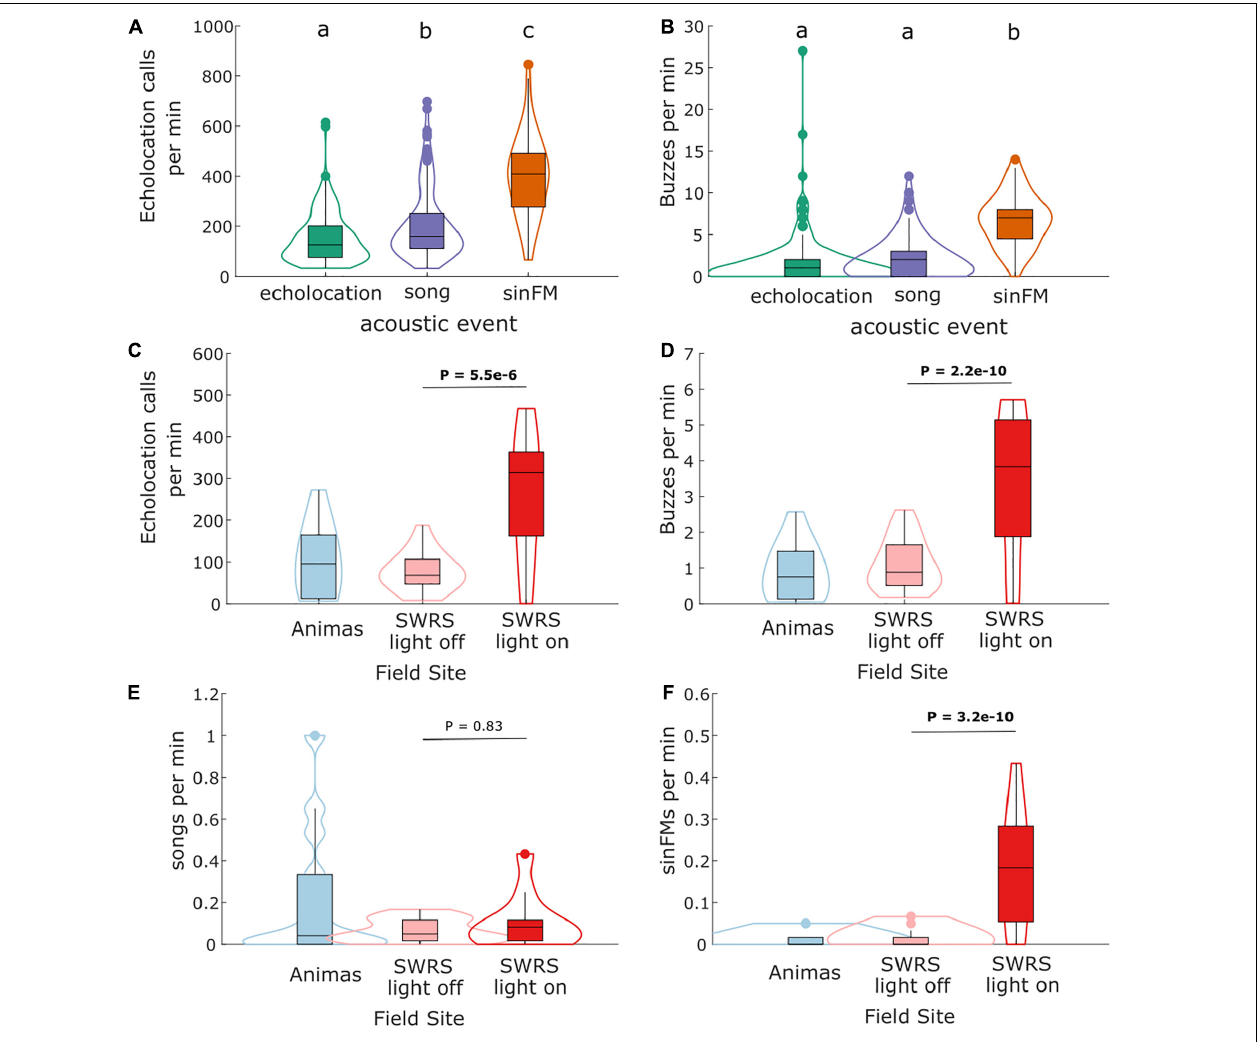
FIGURE 2 | Conditions of song and sinFM production. Comparison of echolocation (A) and feeding buzz (B) prevalence during 1-min intervals with only echolocation ( N = 230) vs. periods with song ( N = 119) or sinFM calls ( N = 68). Data are visualized as violin plots showing probability density functions and box plots showing 10th, 25th, 50th, 75th and 90th percentiles plus outliers. Letters above plots show groupings found to be significantly different using a Kruskal-Wallace test with Tukey-Kramer post hoc comparisons. Rates of echolocation (C) , feeding buzzes (D) , songs (E) and sinFMs (F) at the two field sites with or without supplemental lighting. Note that adding light to the SWRS site increased echolocation recordings, feeding buzzes and sinFMs, but not songs. See Results and Table 1 for